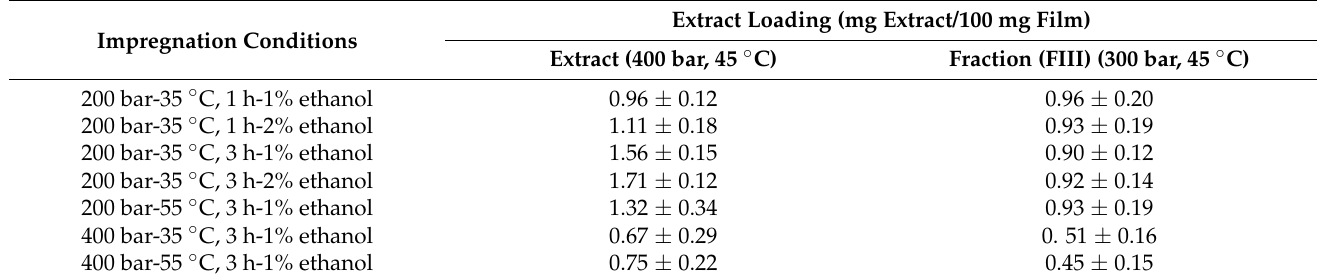
Table 3. Extract loadings achieved into PP films under different sets of conditions using unfraction- ated extract obtained at 400 bar and 45 ◦ C as well as fraction FIII.